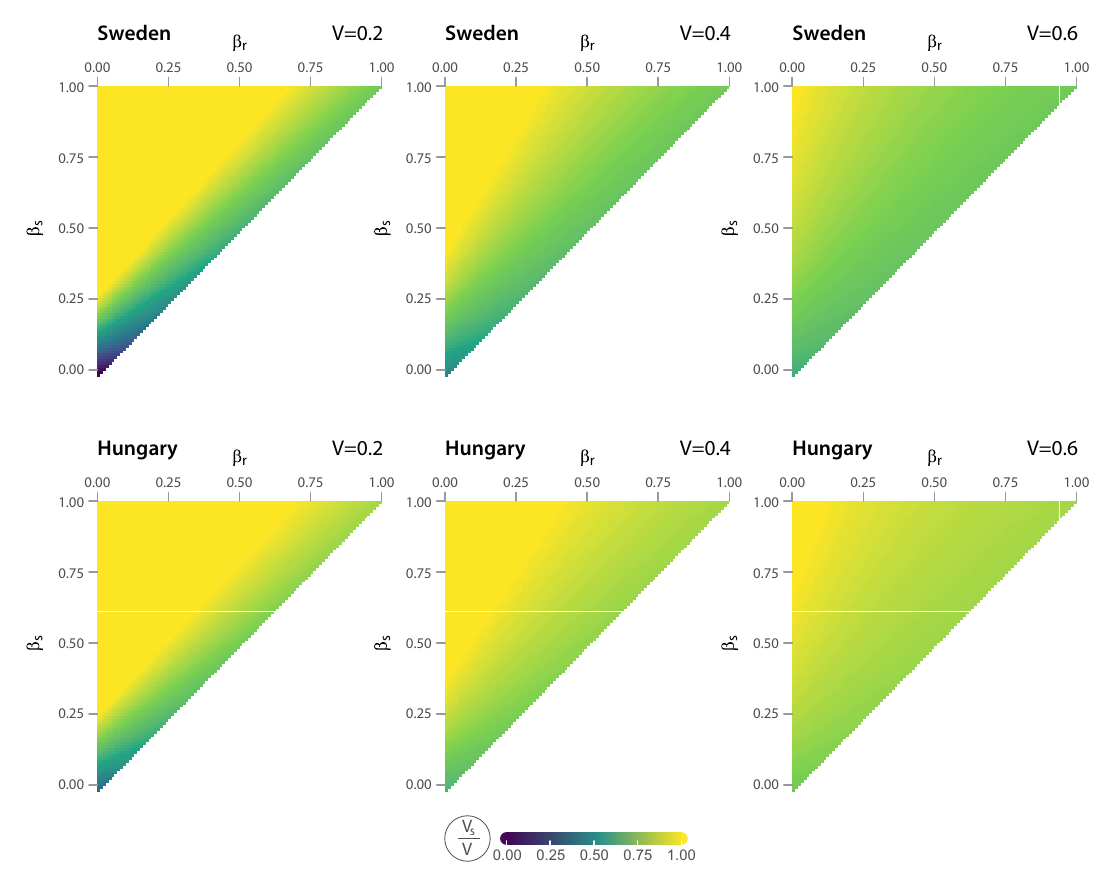
Figure 2. Vaccine allocation by occupation-specific infection risks and available vaccines. Colors represent values of on-site worker fraction in vaccines v s , β r is theoretical infection risk of remote workers, β s is theoretical infection risk of on-site workers. V / L stand for the share of worker population that can be vaccinated with available